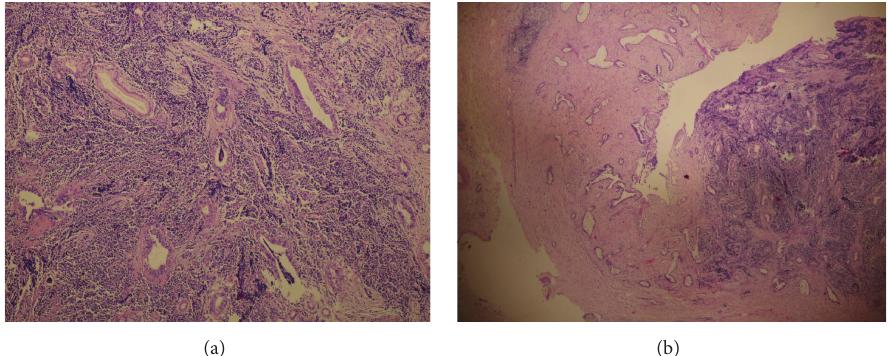
Figure 1: (a) H & E staining showing both NEC and adenocarcinoma component. (b) Scanner view of MANEC in the bile duct (40x).